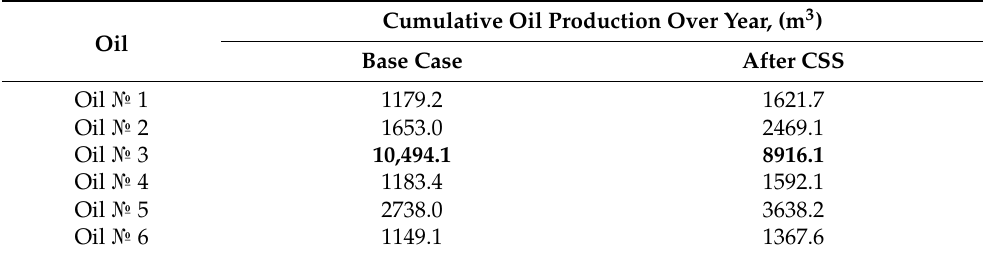
Table 4. Results of calculations of cumulative oil production before and after near-wellbore CSS technology application based on case study.